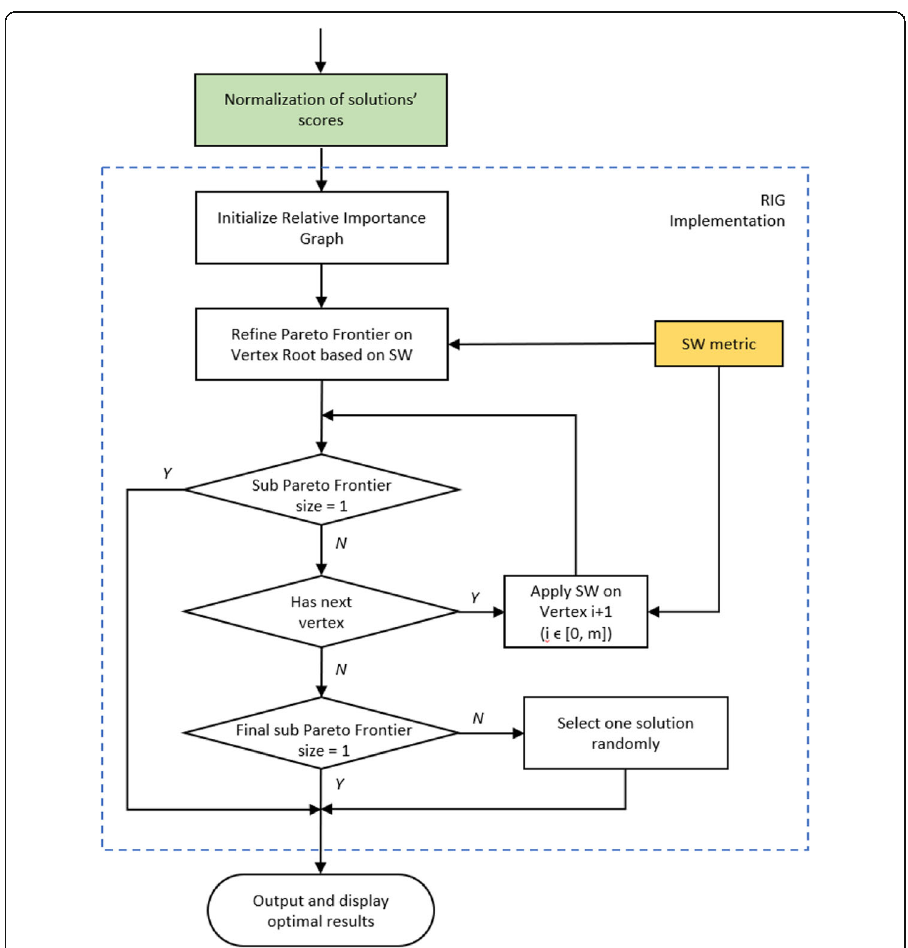
Fig. 3 Flow chart of the selection process of light-plan from PF with